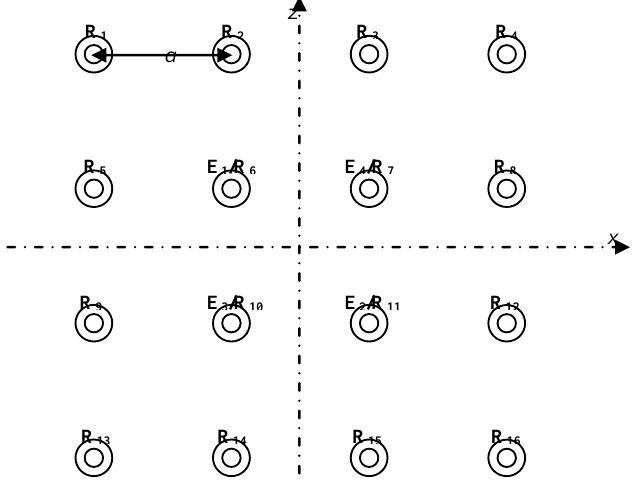
Figure 2. Sensor structure proposed in this